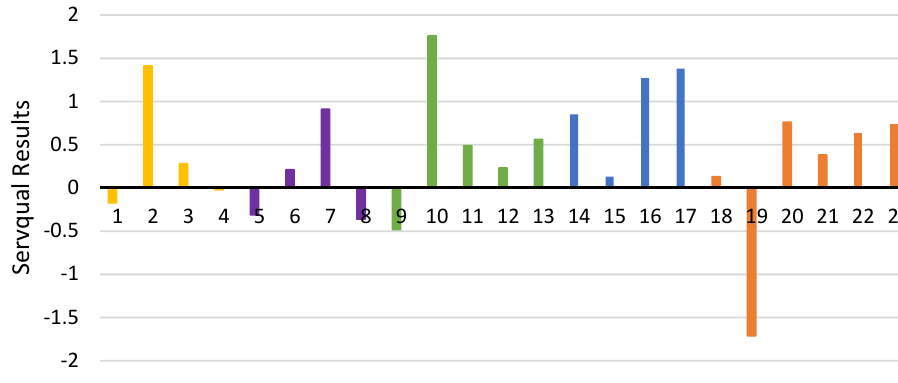
Figure 3. Results of the Servqual analysis.